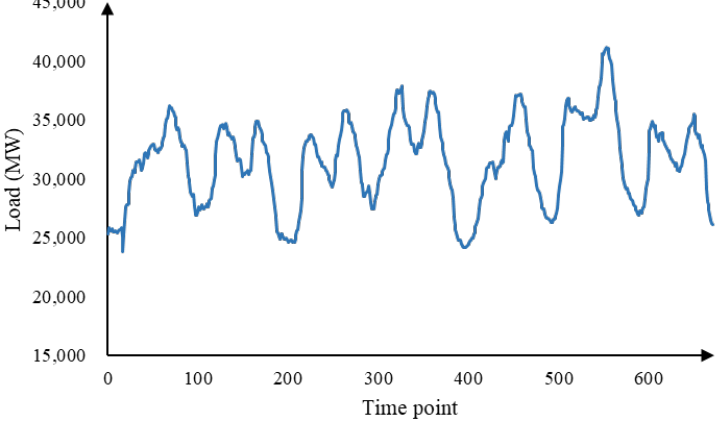
Figure 4. The short-term load data with 15 min intervals (MW).